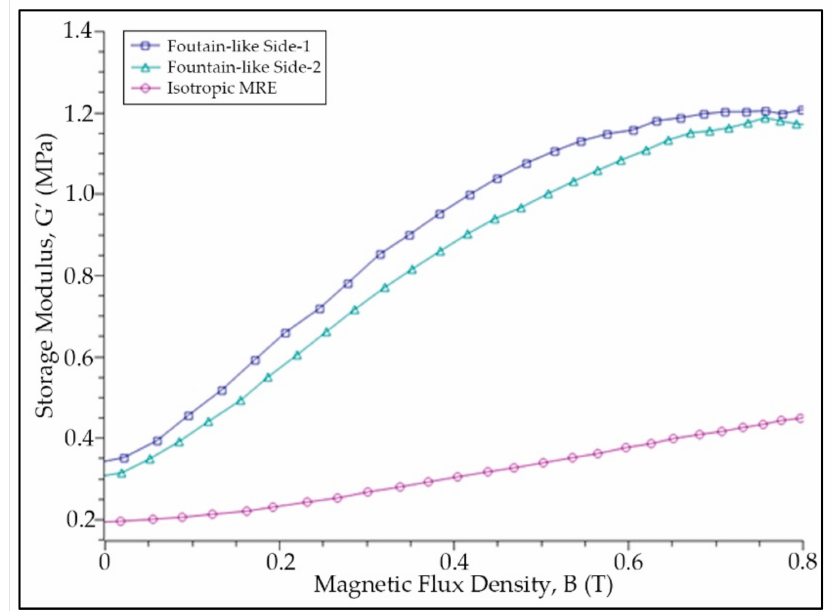
Figure 9. Storage modulus of MRE samples as a function of magnetic field sweep.